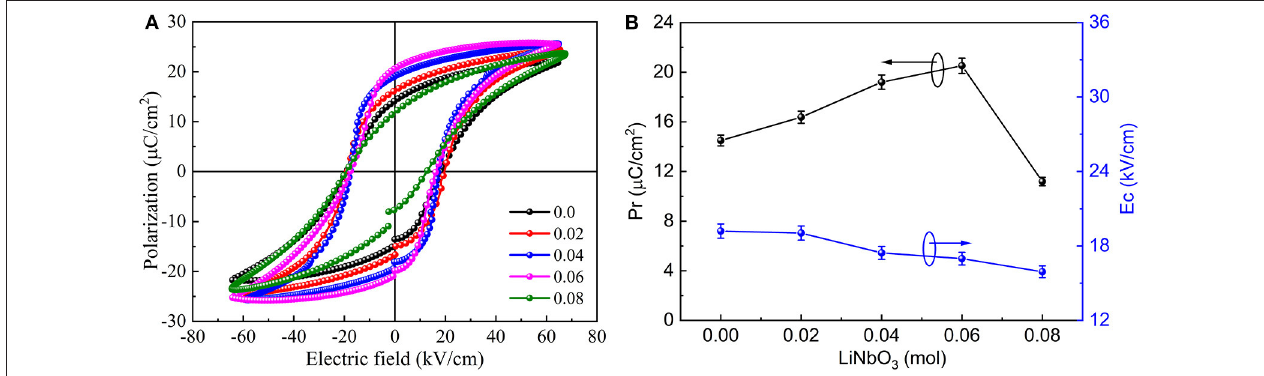
FIGURE 5 | (A) Polarization-electric field hysteresis loops of (1- x )KNBNNO- x LiNbO 3 ( x = 0.00–0.08) ceramics at 10Hz under room temperature; (B) Pr and Ec change with